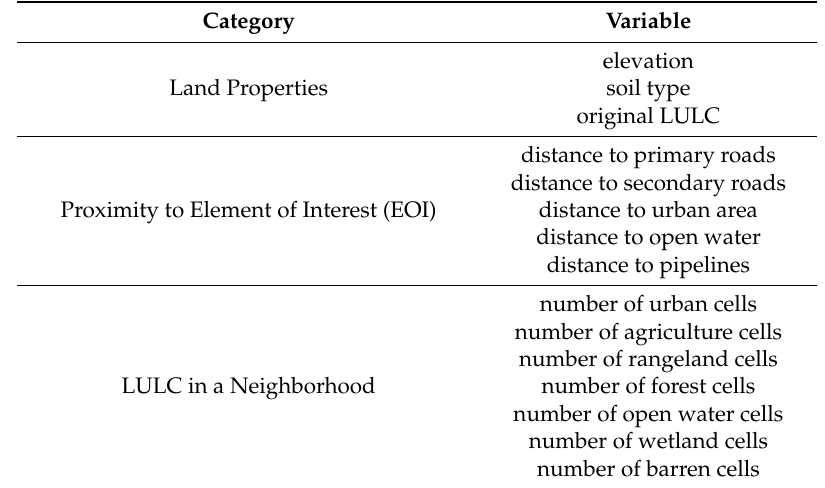
Table 2. The 15 input variables for artificial neural network (ANN)